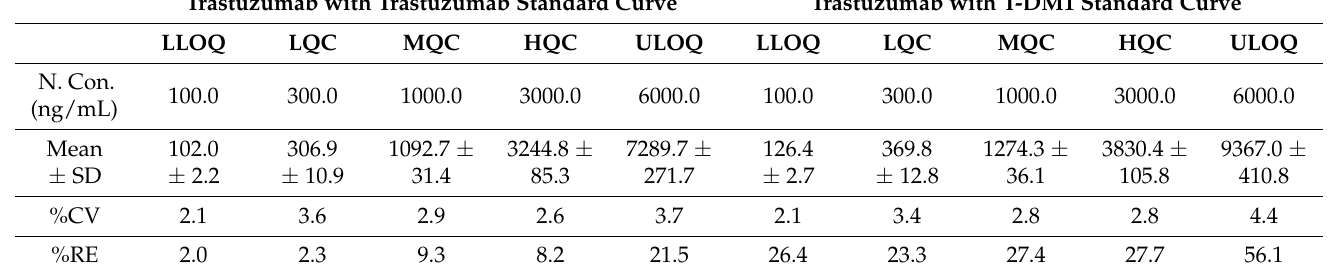
Table 3. Total trastuzumab ELISA results for trastuzumab samples evaluated with T-DM1 curve or trastuzumab